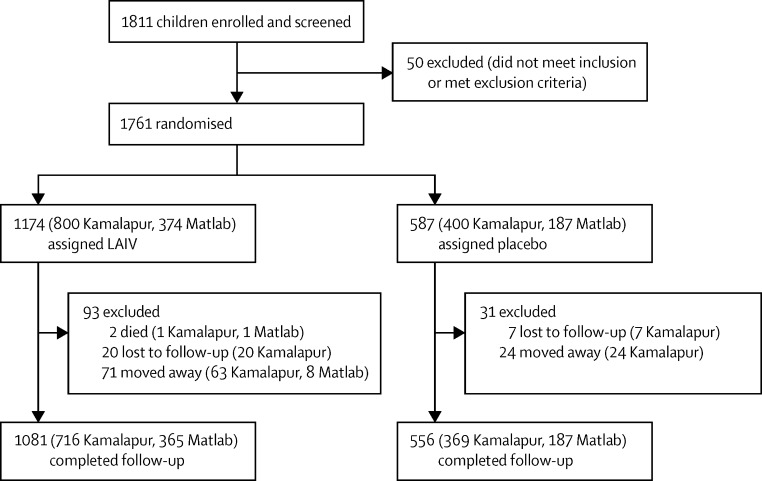
Trial profileLAIV=live attenuated influenza vaccine.